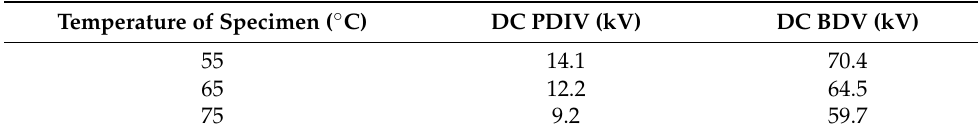
Table 1. Average values of DC partial discharge inception voltage ( PDIV ) and DC breakdown voltage ( BDV ) according to the temperature of the